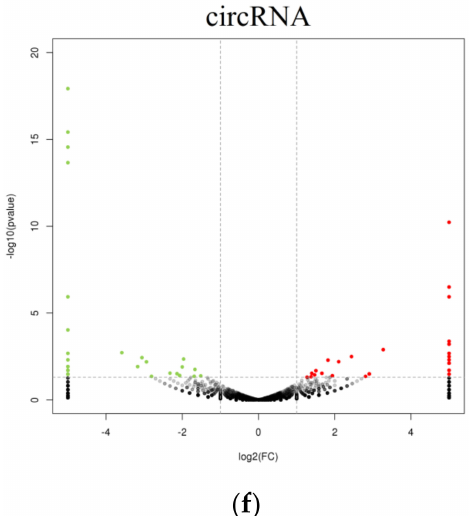
Figure 2. Comparative analysis of mRNAs, lncRNAs, and circRNAs between Huainan (HN) and Duroc × (Landrace × Yorkshire) (DLY) pigs. ( a ) The specific mRNAs (a), lncRNAs ( b ), and circRNAs ( c ) shared between HN and DLY pigs. (b) The mRNAs ( d ), lncRNAs ( e ), and circRNAs ( f ) differentially expressed in HN and DLY pigs. Note: The red points showed the up- regulated mRNA, lncRNA, circRNAs, the green points showed the down-regulated mRNA, lncRNA, circRNAs, and the black points showed the equally expressed mRNA, lncRNA, circRNAs. The vertical dotted lines indicate | log 2 FC | = 1, and the horizontal dotted lines indicate p value = 0.05.